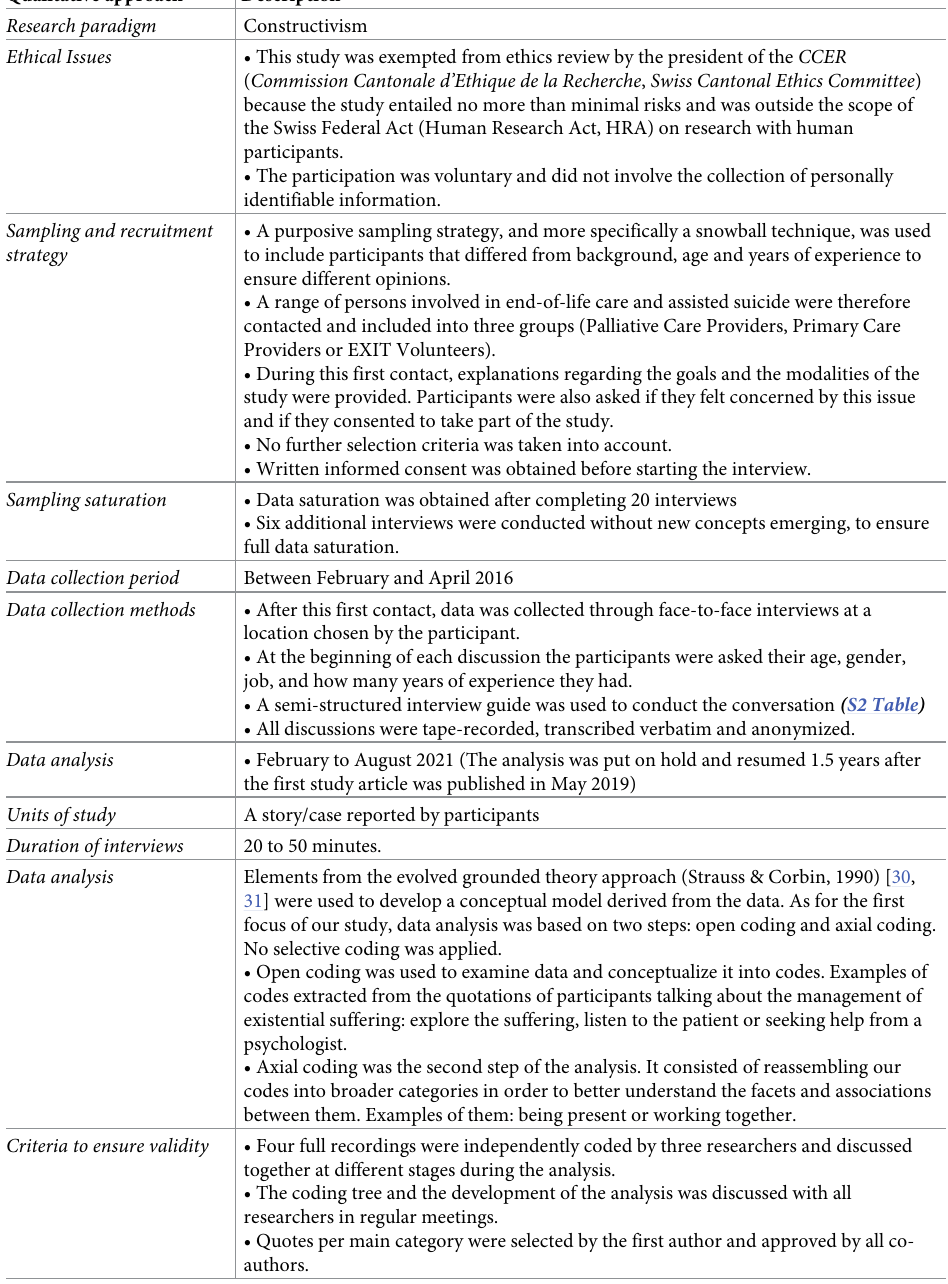
Table 1. Design of the